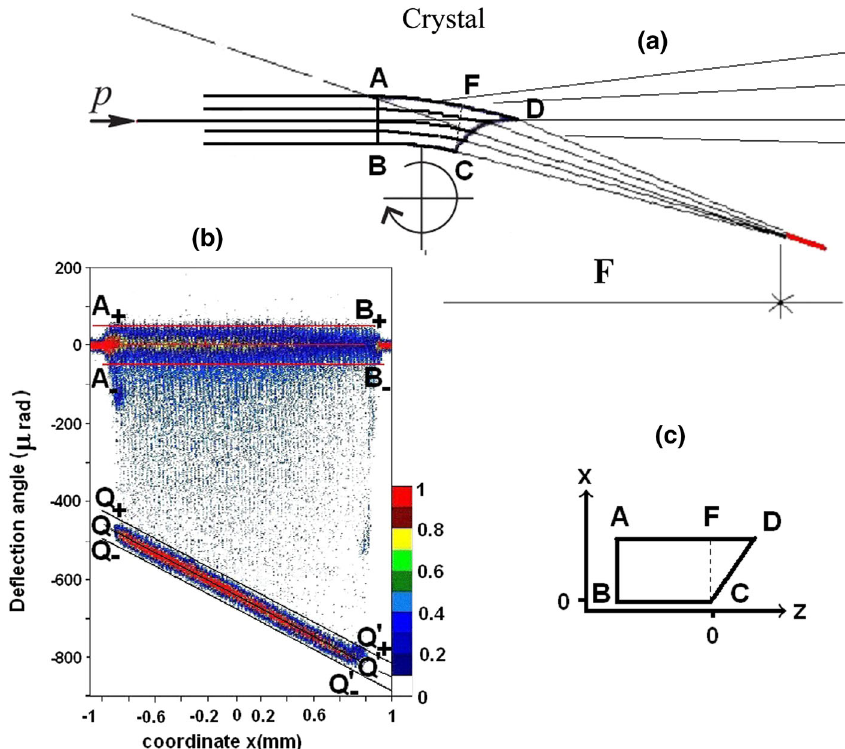
Fig. 2 Focusing crystal: a operation principle; b the measured two-dimensional plot: deflection angle versus horizontal coordinate x ; c focusing crystal before installation in the